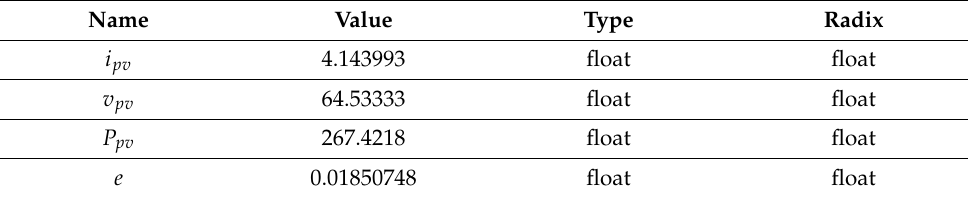
Table 3. The experimental data of Figure 16 at steady-state on the view of Code